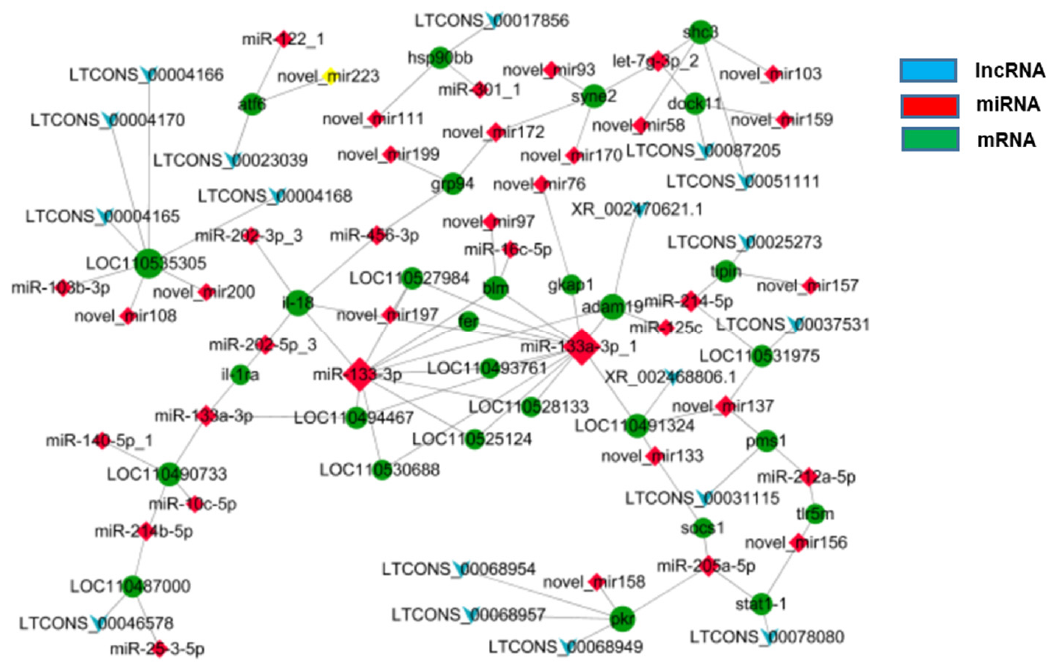
Figure 5. Interacting network analysis of lncRNA-miRNA-mRNA in the head kidney of rainbow trout after post-22.5 °C stress. trout after post-22.5 ◦ C